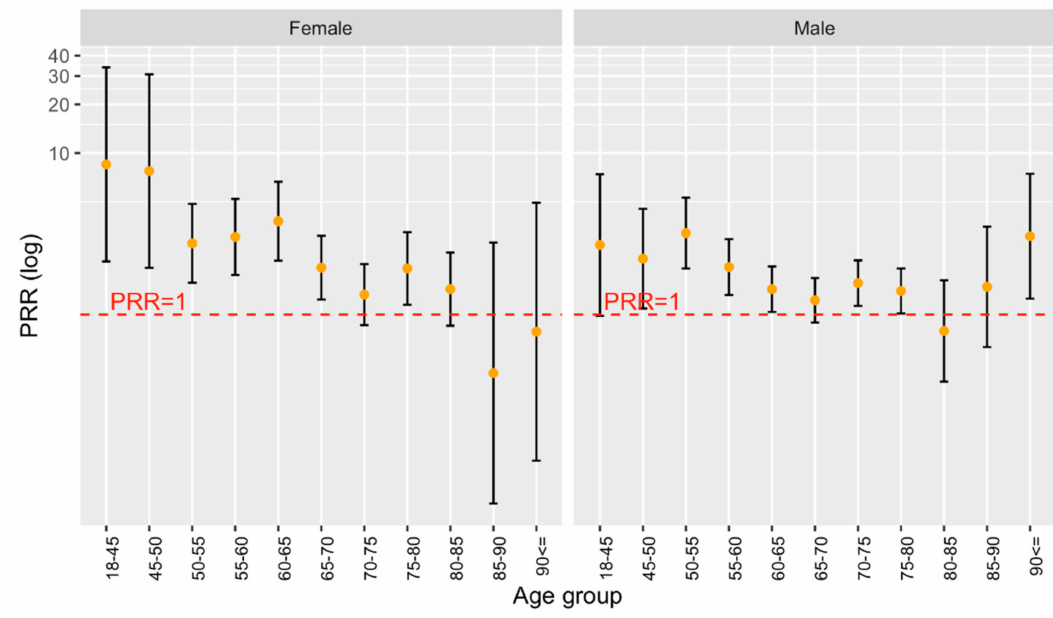
Figure 3. PRR for Diabetes Mellitus by Age group and Sex in Stroke